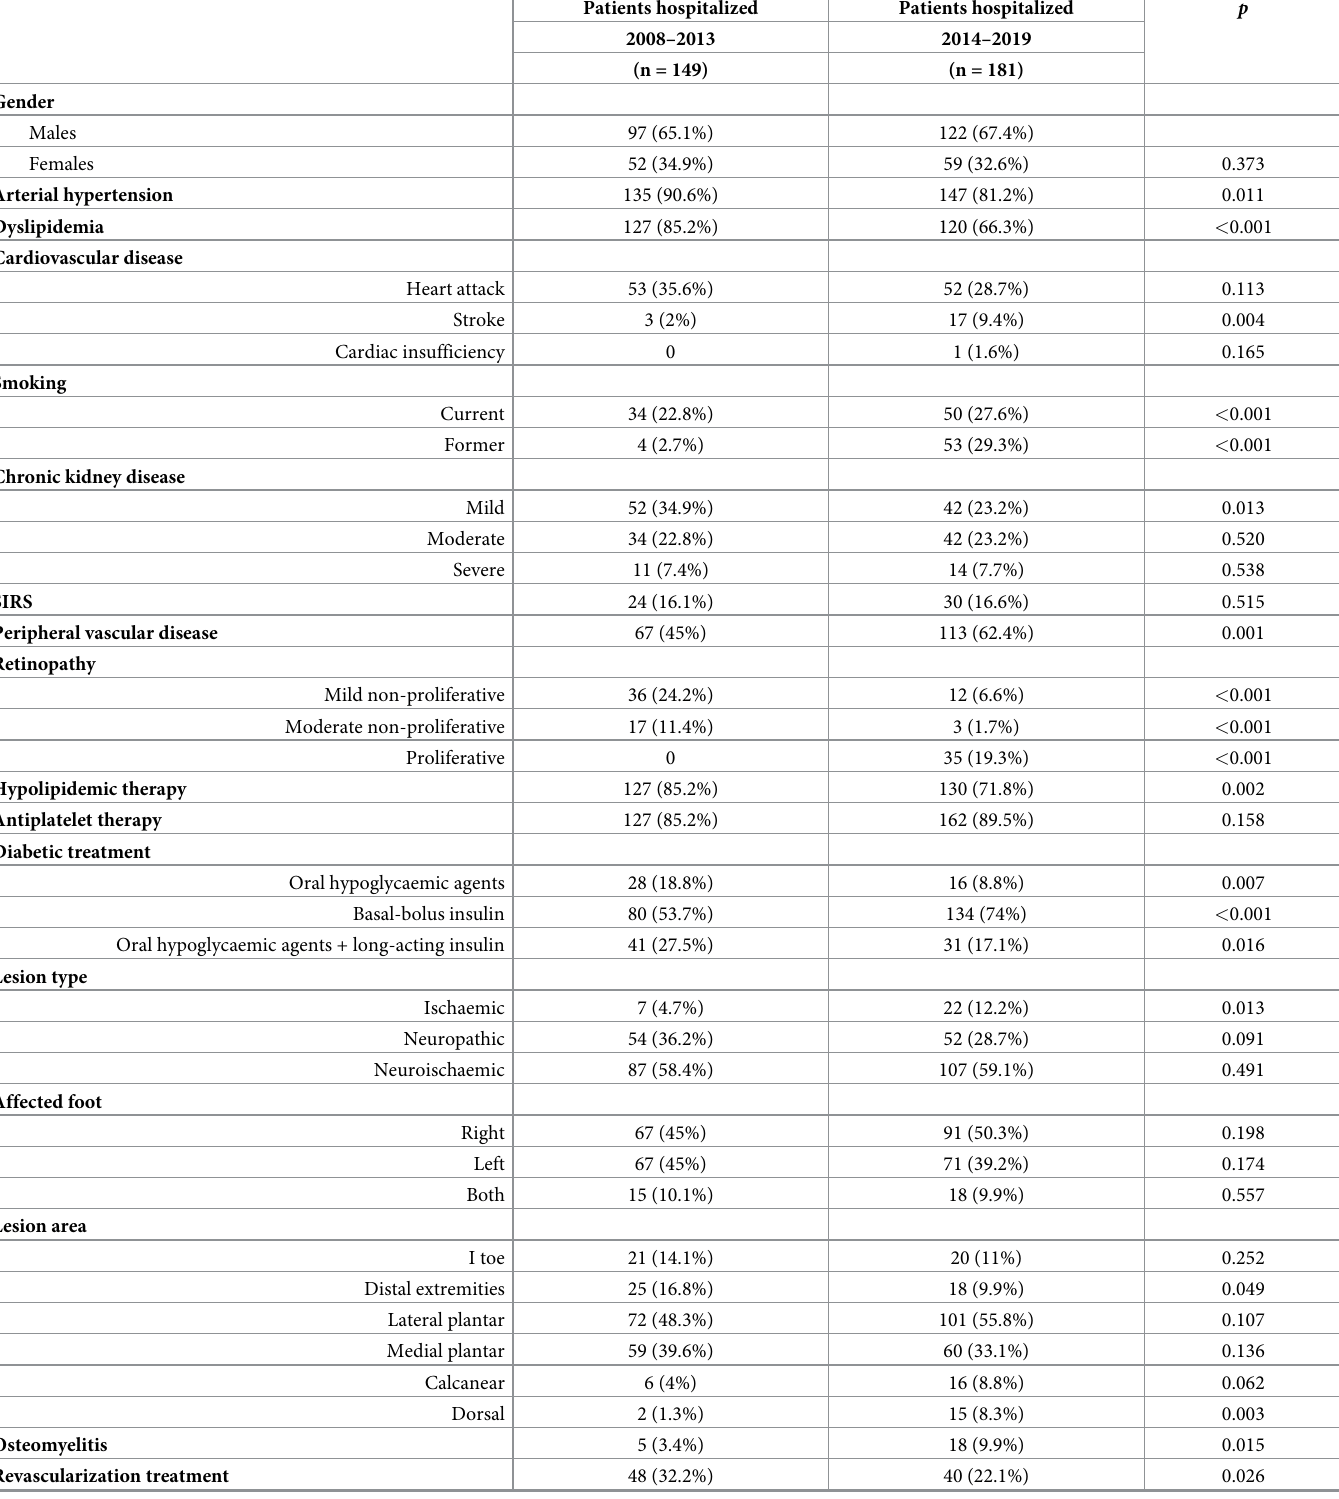
Table 3. General characteristics of all patients with diabetic foot complication divided according to the time of